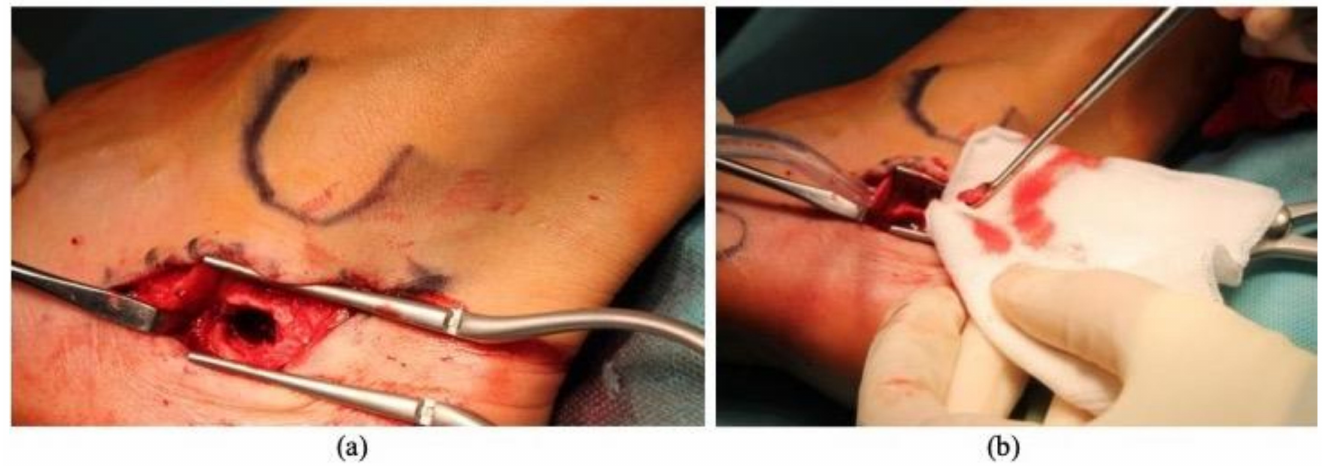
Figure 2. MRI sagittal views. T1 FSE ( a ), PD FSE FS ( b ) and T2* ( c ) sequences. MRI reveals an intraosseous mass (arrows), with homogeneous fat suppression ( a , b ). Discreet focal attenuation within the center of the lesion suggestive for focal calcification ( c ).